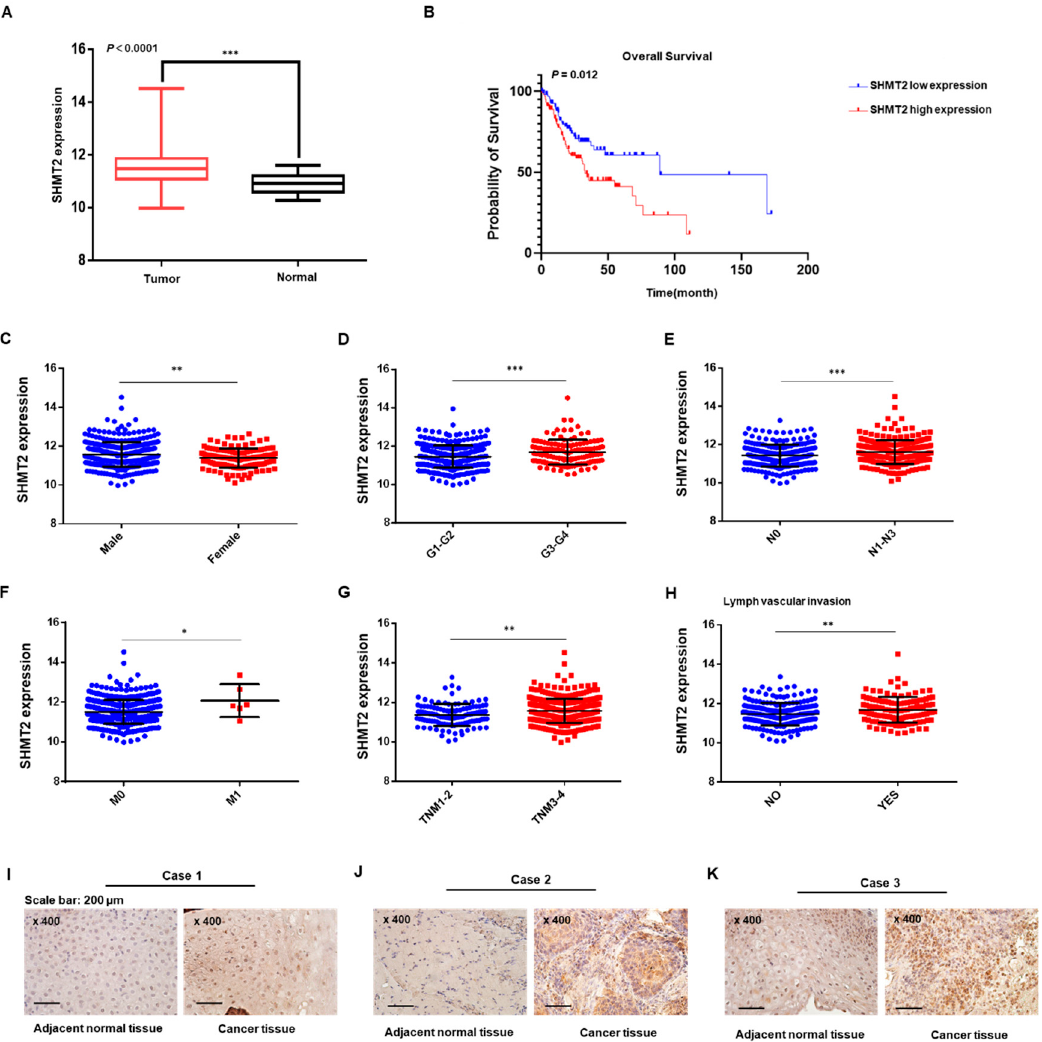
Figure 1. SHMT2 was overexpressed and associated with tumor progression in HNC. ( A ) SHMT2 was expressed significantly more highly in tumor tissues than in normal tissues of HNC in The Cancer Genome Atlas (TCGA) database ( p < 0.0001). ( B ) Patients from TCGA with low SHMT2 expression had a better survival rate than those with high SHMT2 expression ( p = 0.012). ( C – H ) Expression of SHMT2 in HNC based on the TCGA database according to sex, histological grade ( G ), lymph node metastasis ( N ), distant metastasis ( M ), TNM (primary tumor, lymph node, distant metastasis) stage, and lymphovascular invasion. ( I – K ). The SHMT2 levels of three HNC tissue samples and their adjacent normal tissue samples were examined by immunohistochemistry. p < 0.05 was recognized as statistically significant (* p < 0.05, ** p < 0.01, *** p < 0.001).